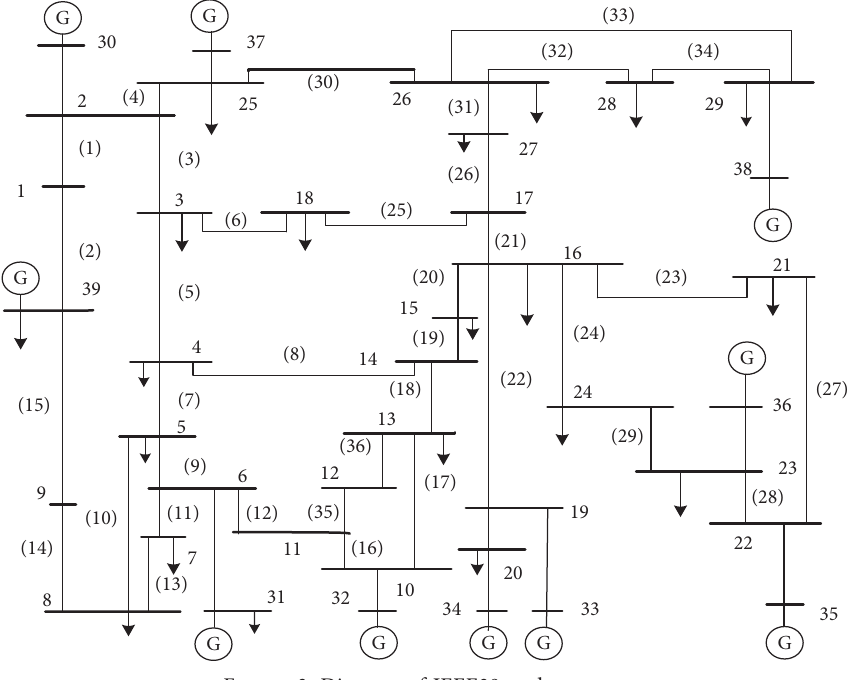
Figure 3: Diagram of IEEE39 node system. Table 1: Cluster center of the example.